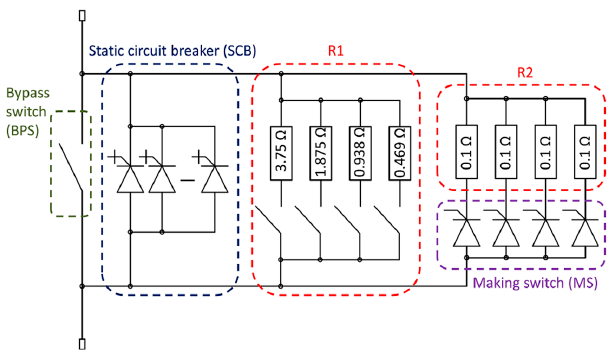
Figure 3. Simplified scheme of a CS SNU as built and installed [5]. The SCB consists in eight parallel branches of electronic switches based on IGCTs with supporting snubbers and protections. The connectors in series with the R1 resistors can be operated only without flowing current.